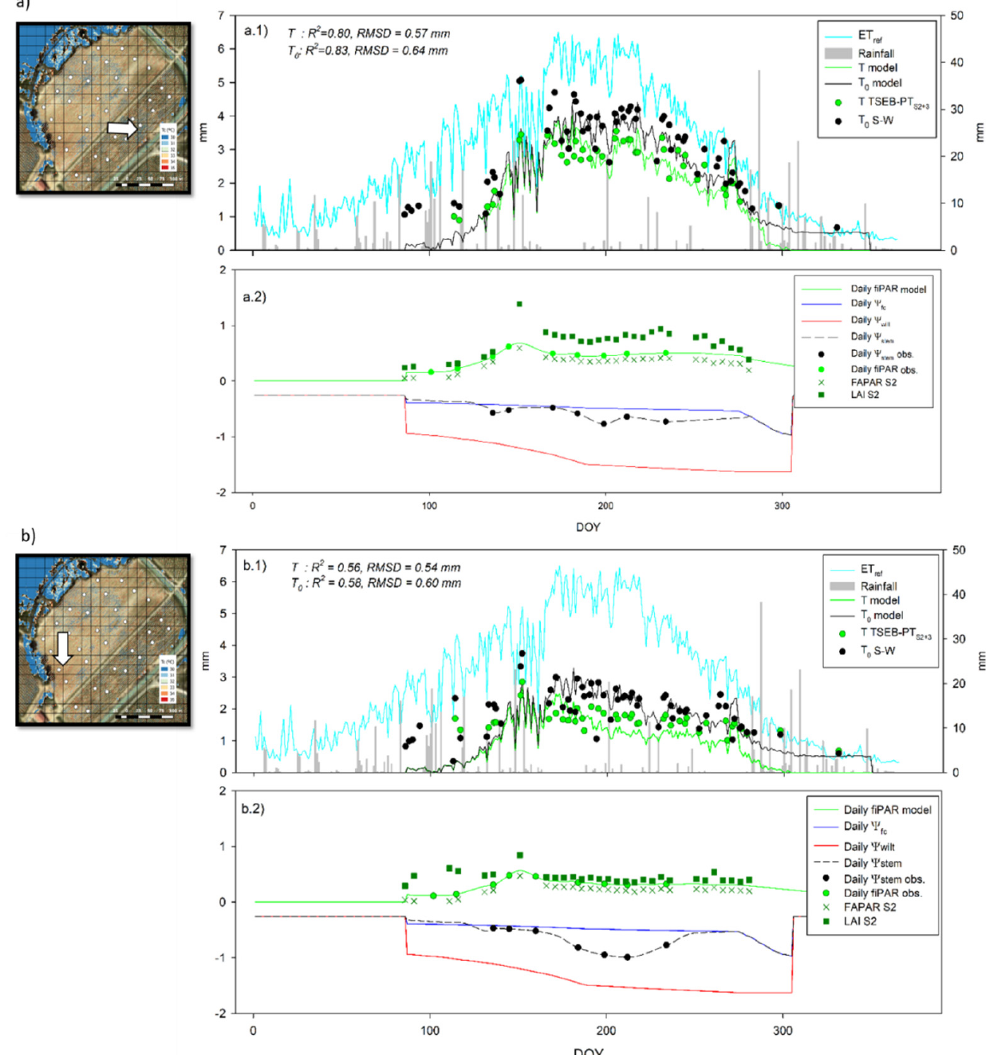
Figure 3. Seasonal variations in actual and potential transpiration (T, T 0 ) estimated by the TSEB-PT S2 + 3 and S–W models, respectively, and validated against the vine consumption model for ( a ) well-watered and ( b ) stressed vines. ( a.2 ) and ( b.2 ) show seasonal measurements and simulations of Ψ stem and daily fiPAR, and estimates of leaf area index (LAI) and FAPAR based on the biophysical processor of S2. RMSD represents the root mean square deviation (mm season − 1 ). ET ref is the reference evapotranspiration obtained from the weather station using the Penman–Monteith equation. Ψ fc and Ψ wilt respectively correspond to the soil water potential at field capacity and to the lowest plant water potential at wilting point, when transpiration is null.